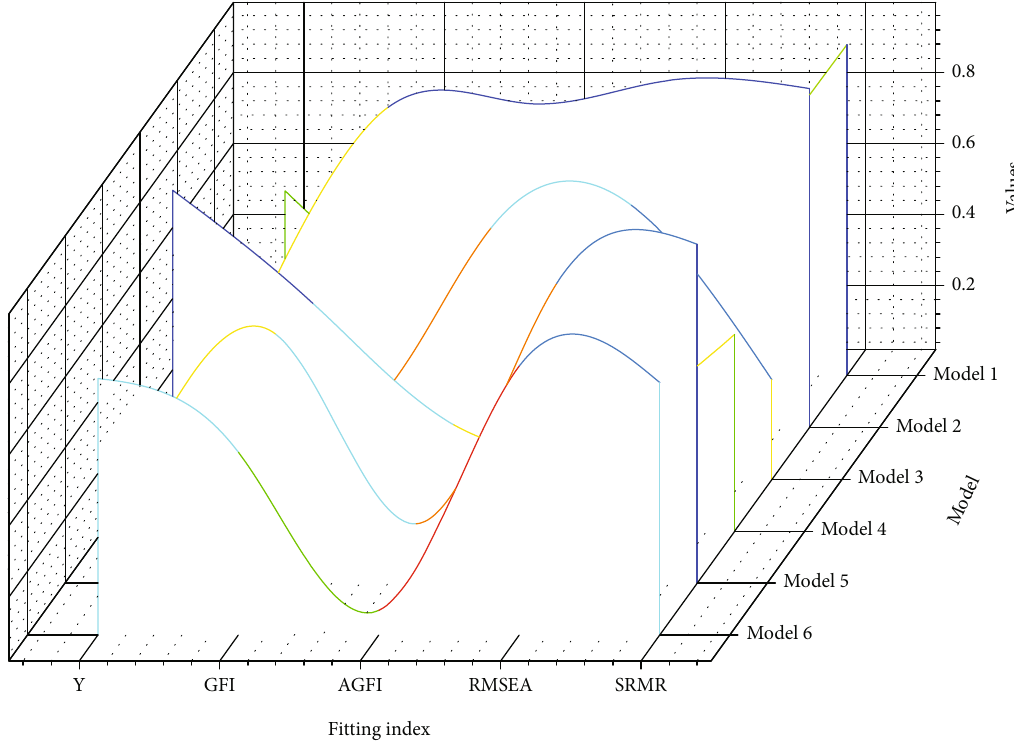
Figure 7: Comparison of fi t indices of di ff erent